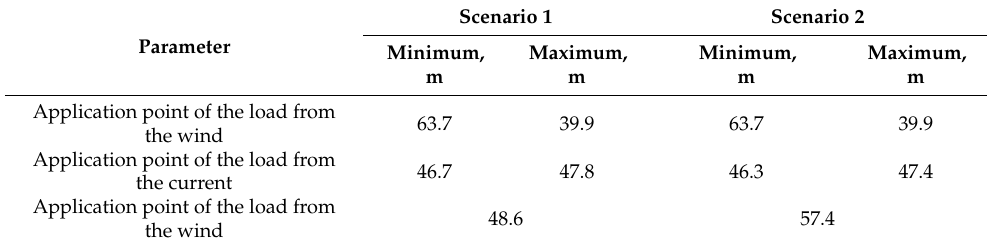
Table 12. Application points of integrated loads on platforms according to Scenario 1 and Scenario 2.